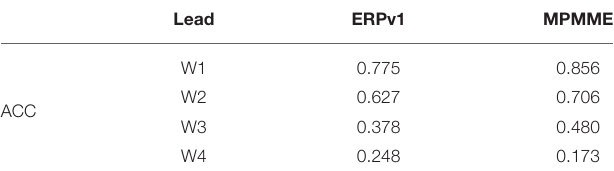
TABLE 1 | Anomaly correlation coefficient (ACC) of predicted weekly mean rainfall over the monsoon zone.